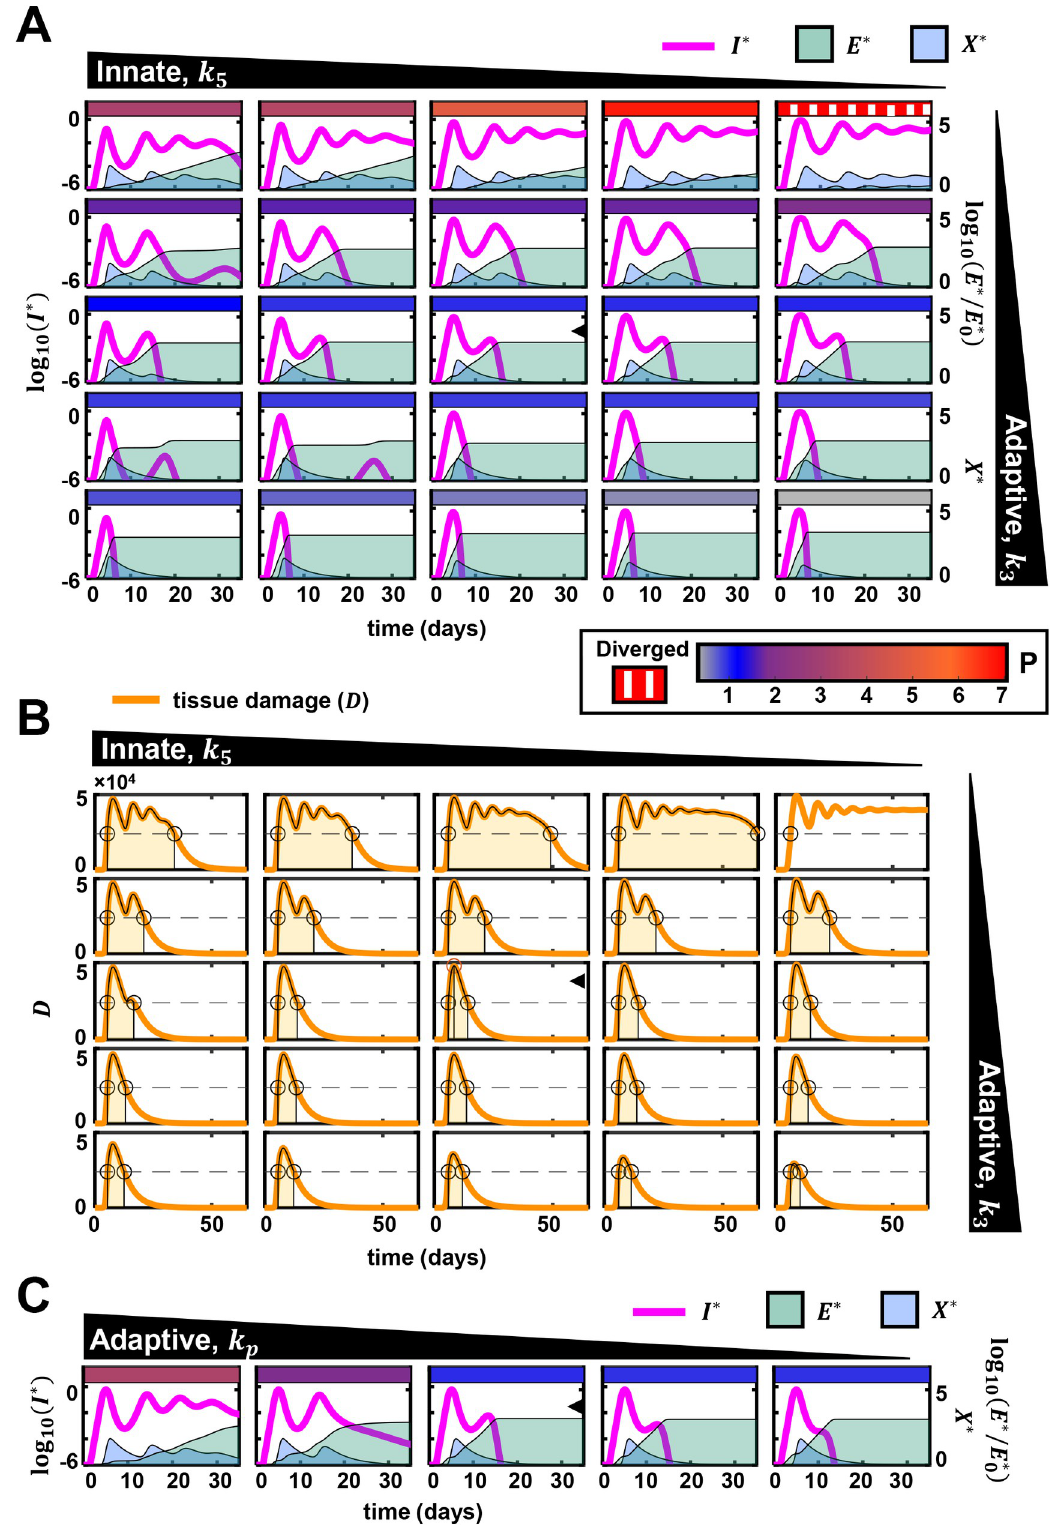
Fig 4. Variations in innate and CD8 T-cell responses capture disease heterogeneity. (A) Effect of variation of parameters determining the strengths of innate and CD8 T cell responses on the trajectory of the infection. The black annotated triangles at